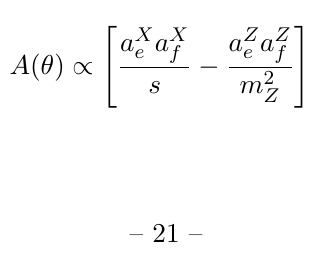
Here c is the scattering angle, and k the space-momentum of the particles in the (cid:12)nal (cid:18) p s (cid:29) m the contribution coming from X exchange can be state. In the region (cid:22)